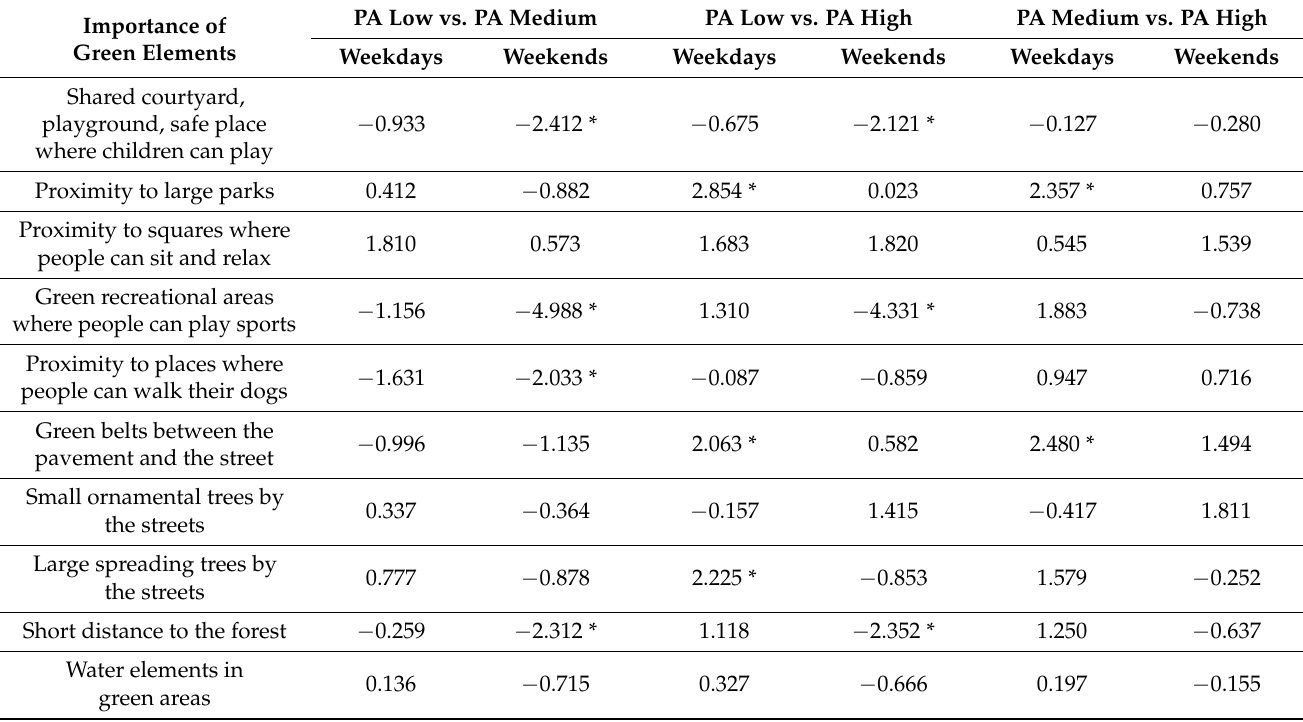
Table 4. Importance of green elements comparison of people with different activity levels (pairwise comparisons using the Mann-Whitney U-value